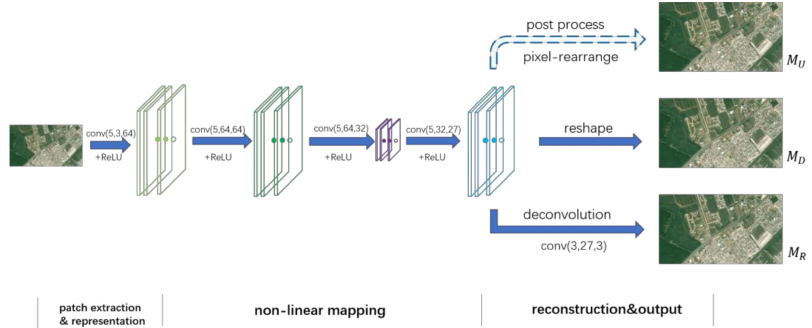
Figure 1. Proposed network structure. “conv ( m , n , k ) + ReLU” in the figure indicates the input feature maps (or image block at the beginning), which are sent to a convolution layer ( m is the kernel size, n and k are the number of layers of feature maps for the input and output, respectively) and an activation